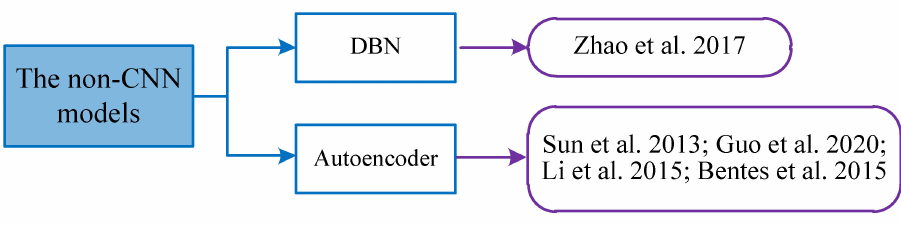
Figure 9. The non-CNN models [37–41].